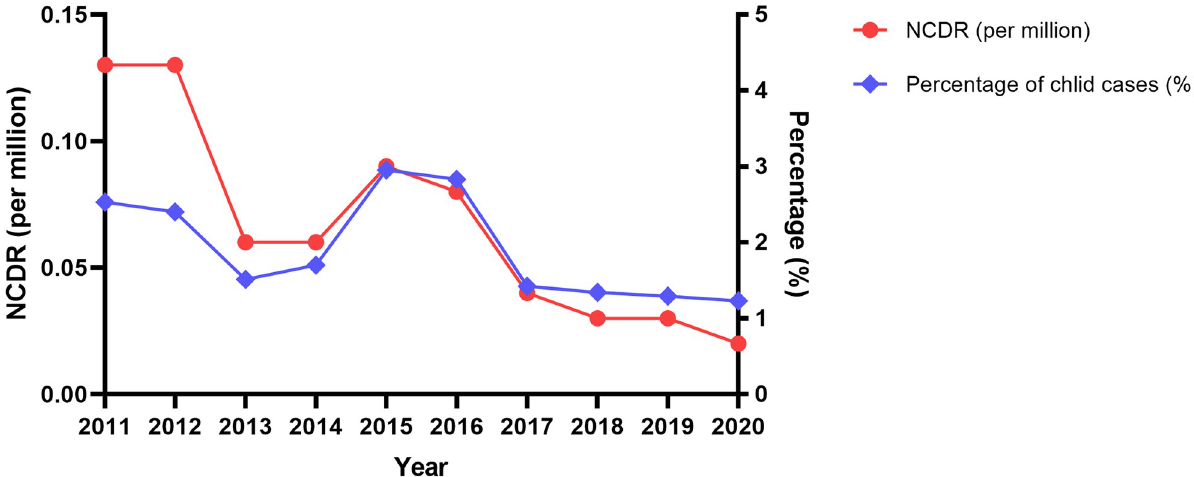
Fig 1. Temporal trend of pediatric leprosy new case detection rates and the proportion of children in new leprosy cases in China, 2011–2020.